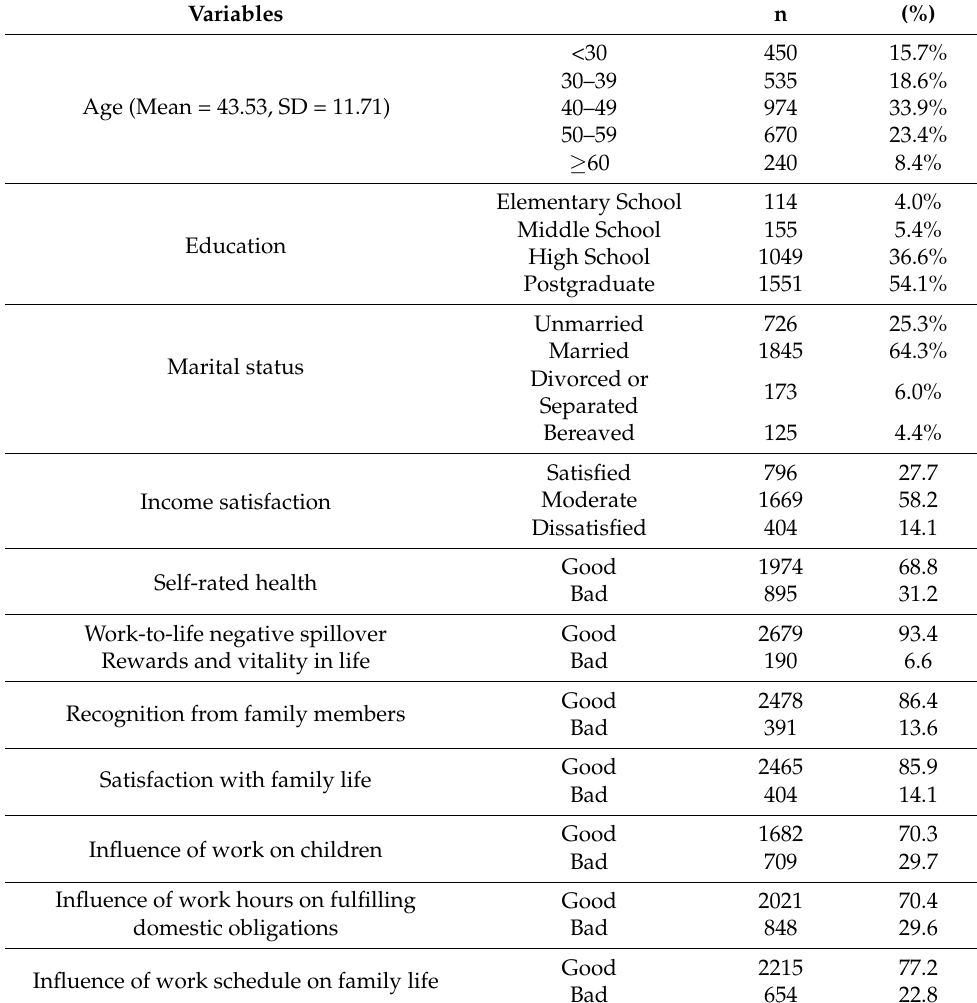
Table 1. Characteristics of socio-demographic data (N = 2869). Variables